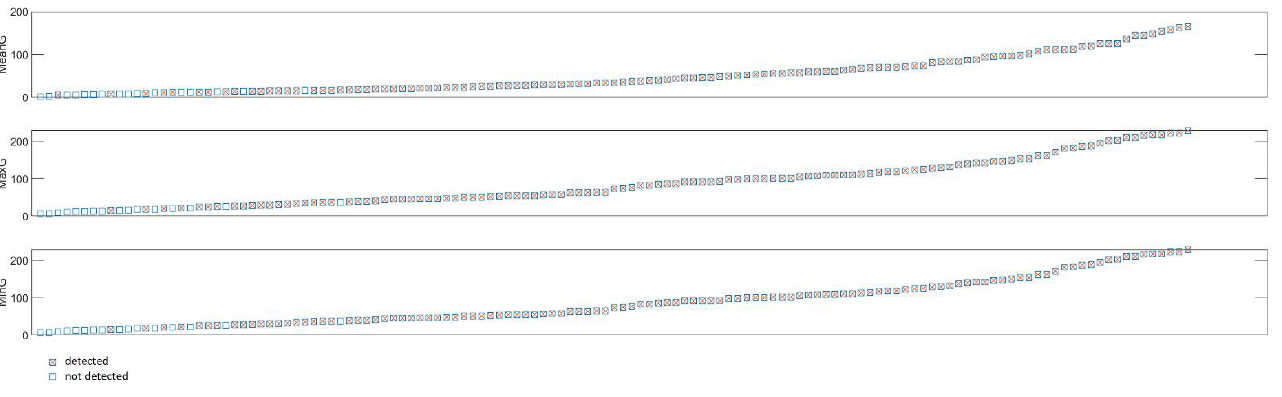
Figure 12. Analysis of the F-points’ detection ability, depending on the spectral response for green.